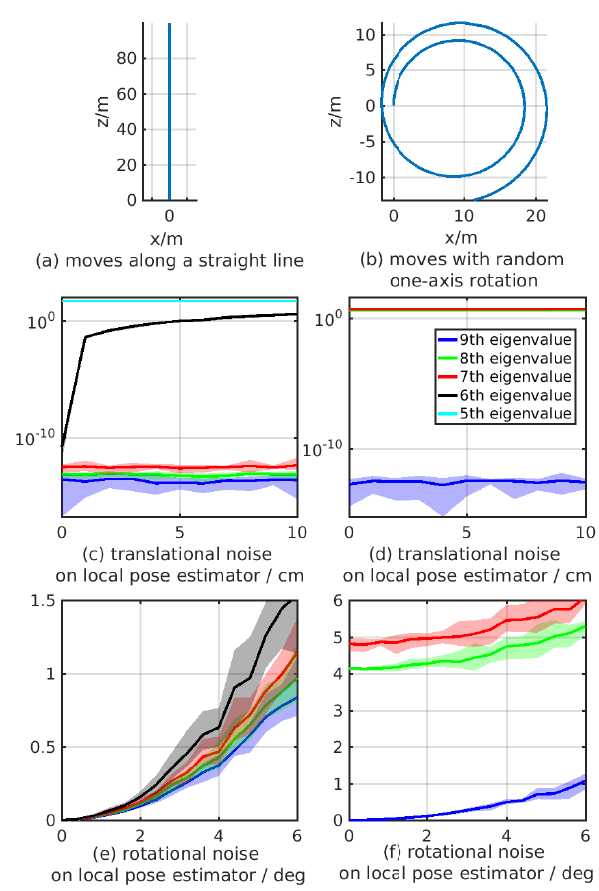
Figure 3. Eigenvalues of the system calculated on two degenerated trajectories with different measurement noises. The curves in each figures denote the means of the eigenvalues and the colored region surrounding the curve represents the statistic of 200